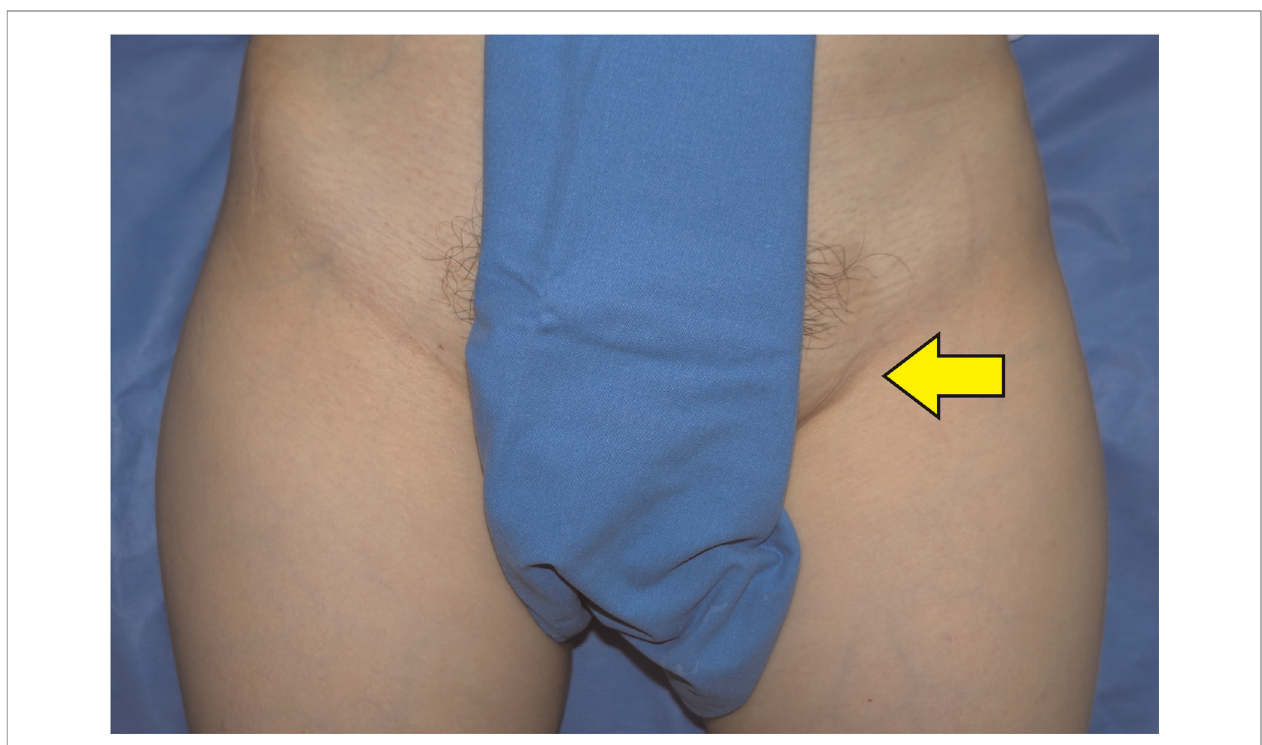
FIGURE 1 | Preoperative fi ndings: a 3×4-cm, soft, nontender, mobile, and palpated mass was found in the left inguinal area